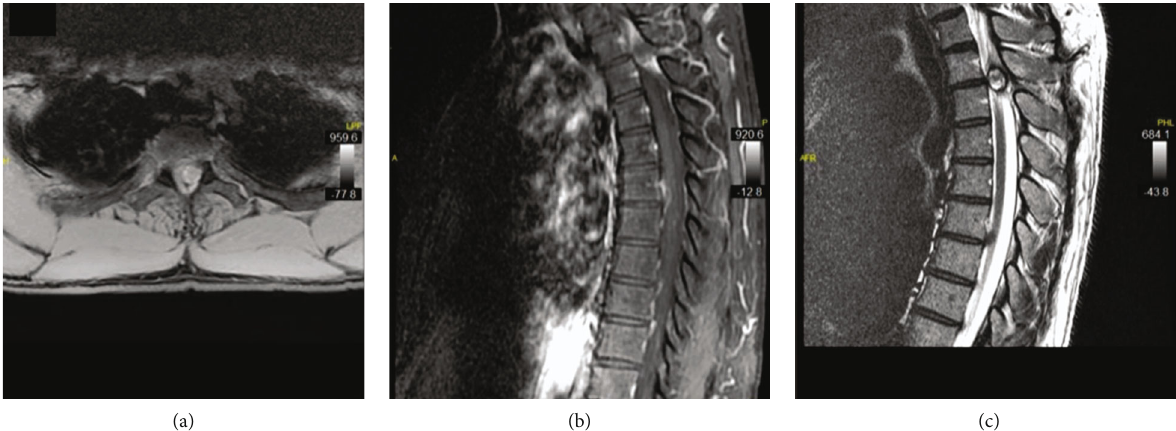
Figure 1: (a) Axial T1-weighted MRI, (b) sagittal T1-weighted MRI, and (c) sagittal T2-weighted and short tau inverted recover MRI images demonstrating a large left T2-T3 synovial facet cyst within the spinal canal.